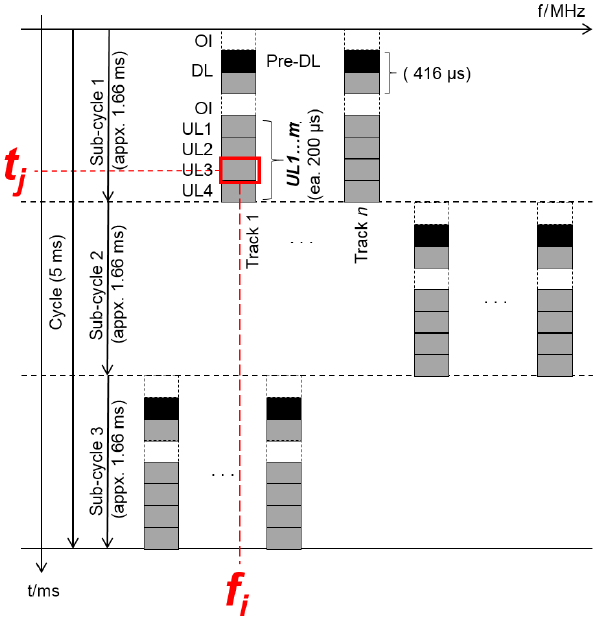
Figure 5. IO-Link Wireless medium access. OI = Organization In- terval, DL = Downlink, UL =